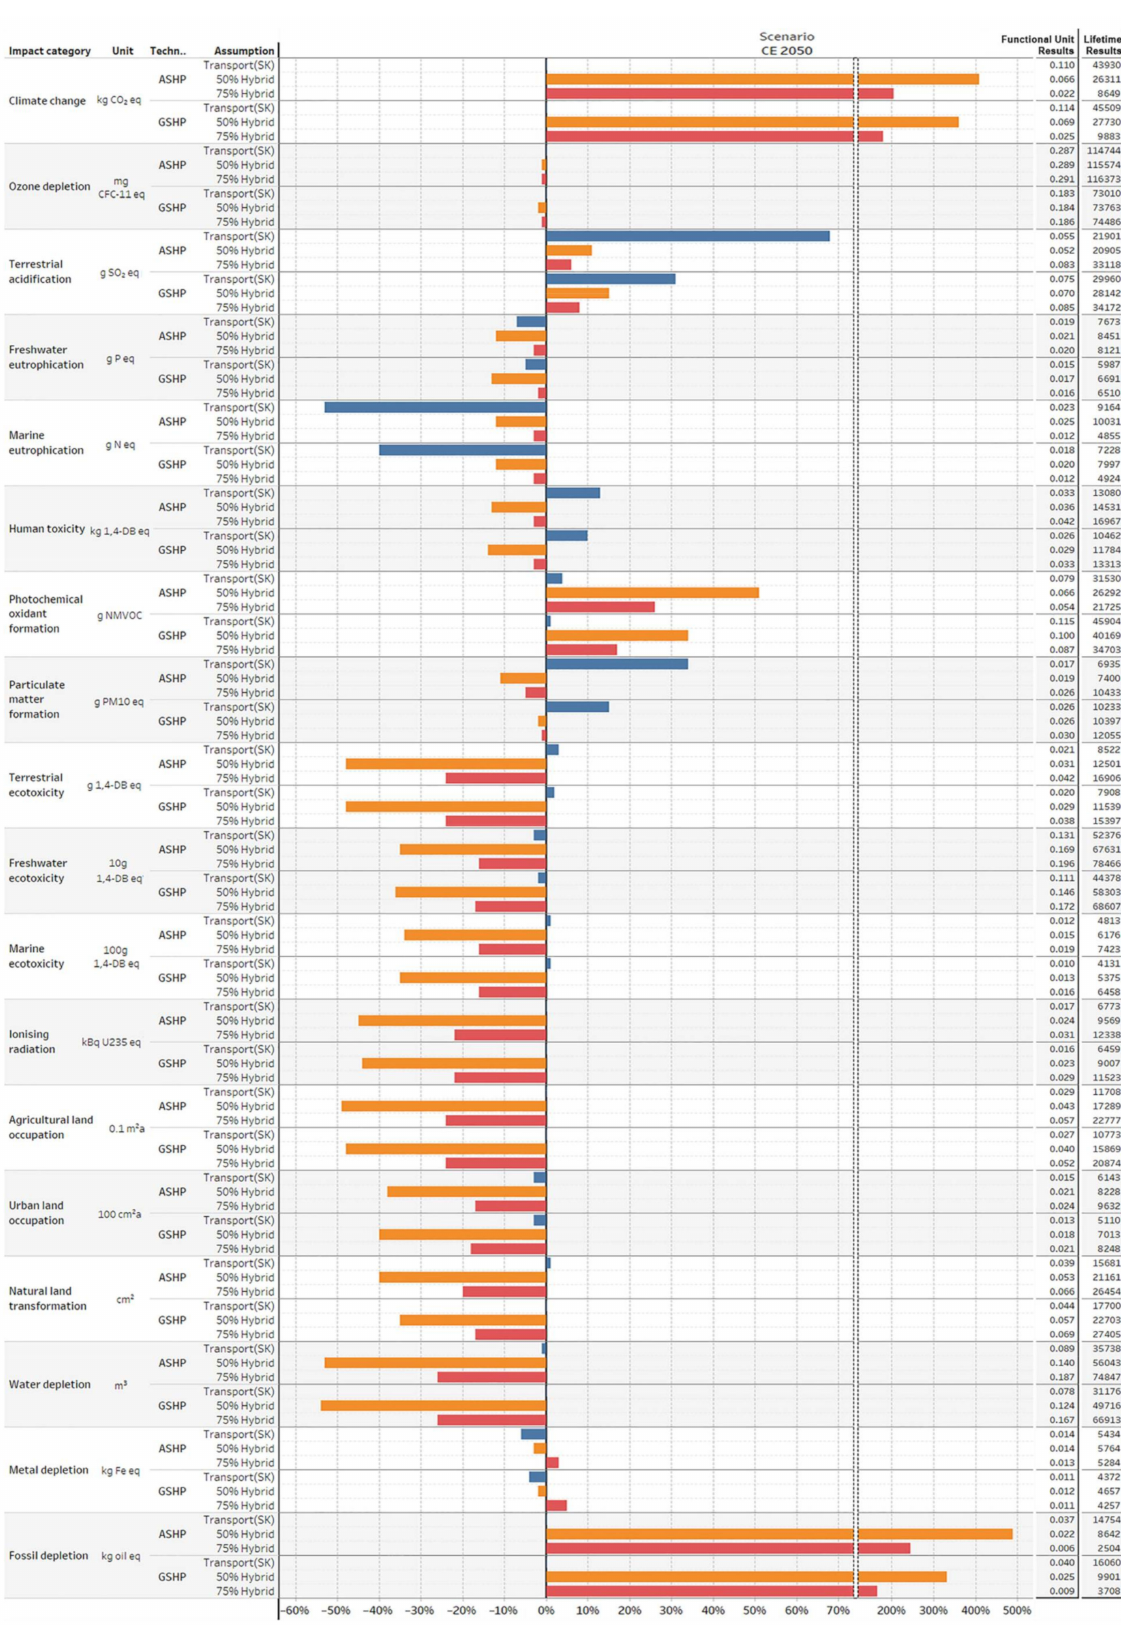
Figure 7. Lifecycle environmental impact change of Transport (SK) and Hybrid scenarios according to CE